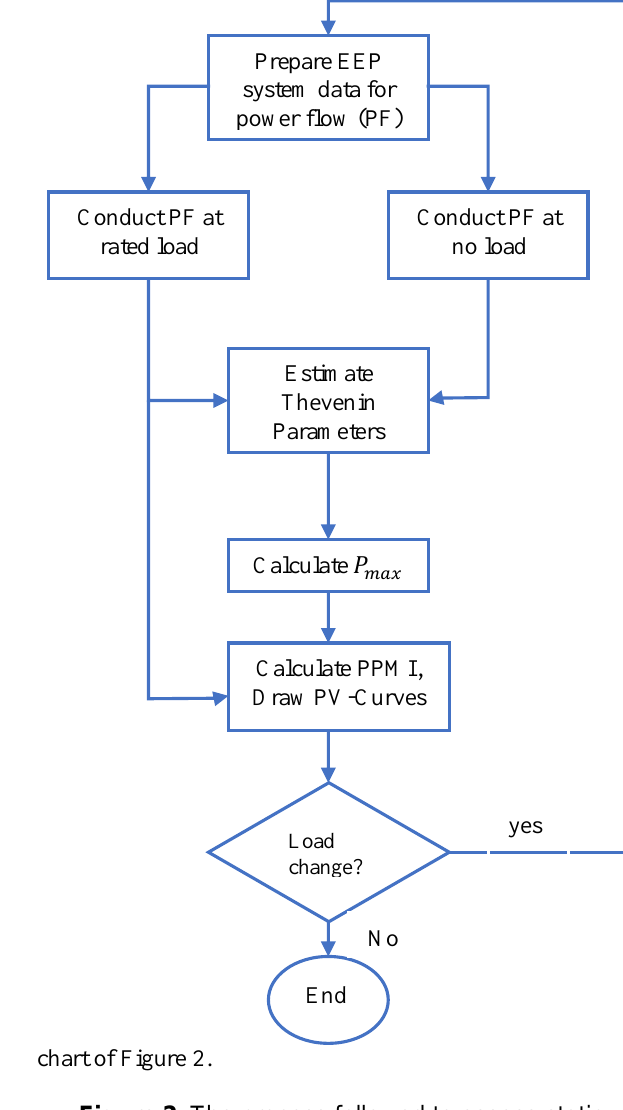
Figure 2. The process followed to assess static voltage stability of EEP